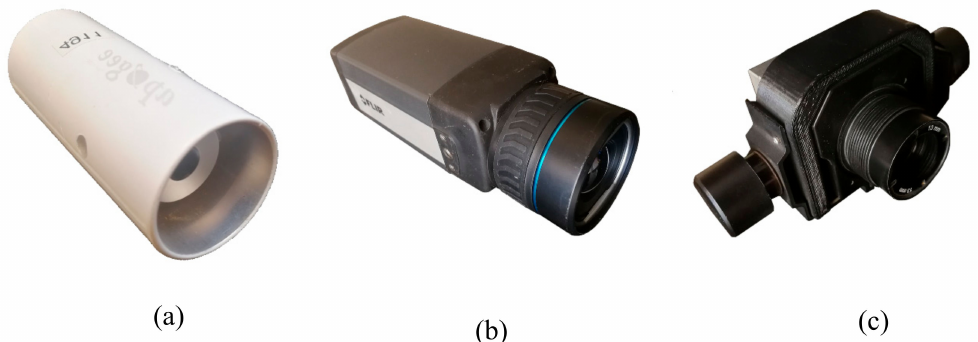
Figure 1. Instruments calibrated during this study ( a ) Apogee SI-111 infrared radiometer, ( b ) FLIR A655sc uncooled radiometric thermal camera, ( c ) TeAx 640 miniature uncooled radiometric thermal camera for unmanned aerial vehicle (UAV)